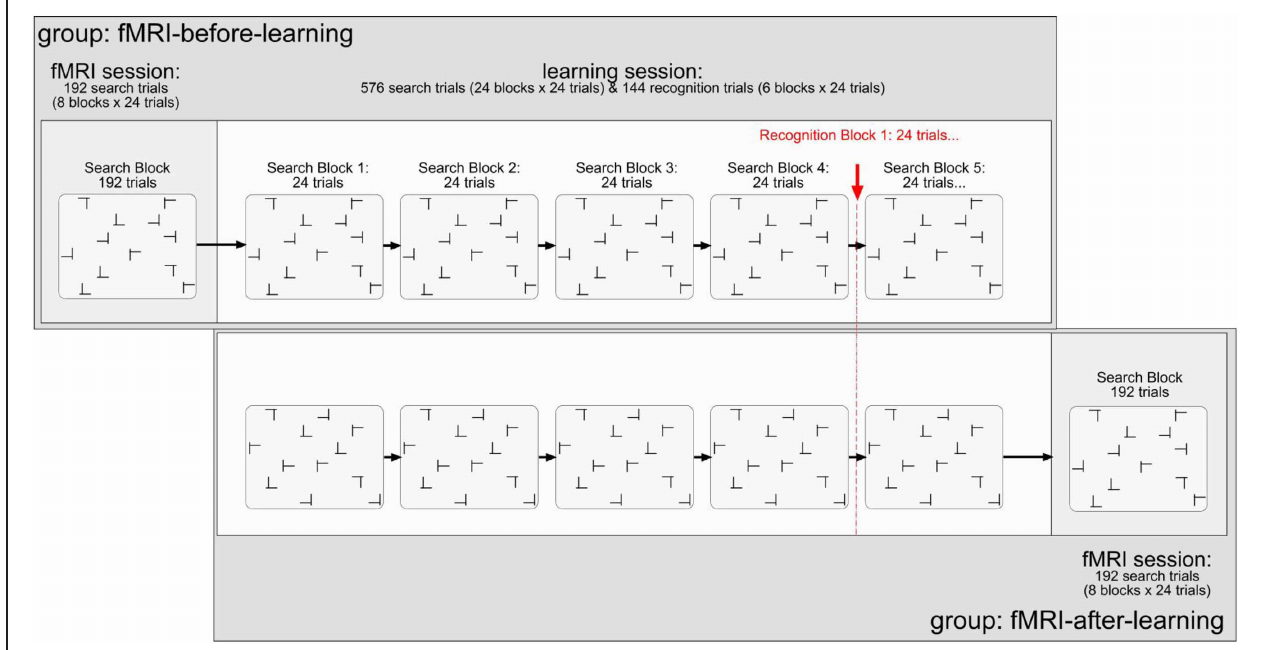
FIGURE 1 | Illustration of the stimuli and design used in the present experiment. Explanations are given in the